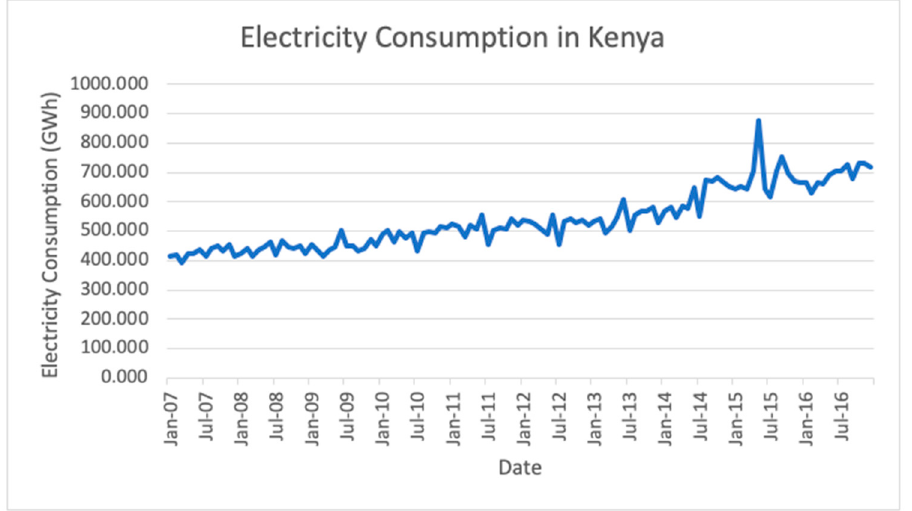
Figure 11. Electricity consumption in Kenya from 2007 to 2016.